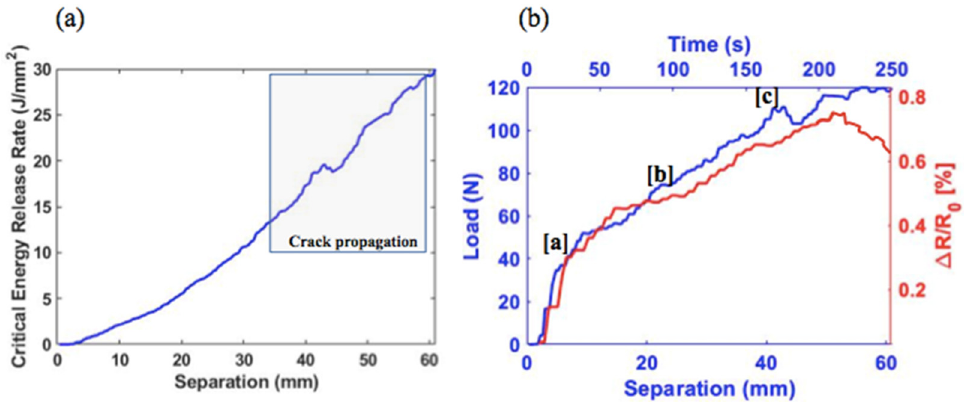
Figure 10. GFRP composite ( a ) mode I critical energy release rate, ( b ) mode I fracture propagation and percentage of resistance change where the slight charge release is labeled as [a]; upon further loading, crack propagates and more charge release was observed at both sections [b] and [c].